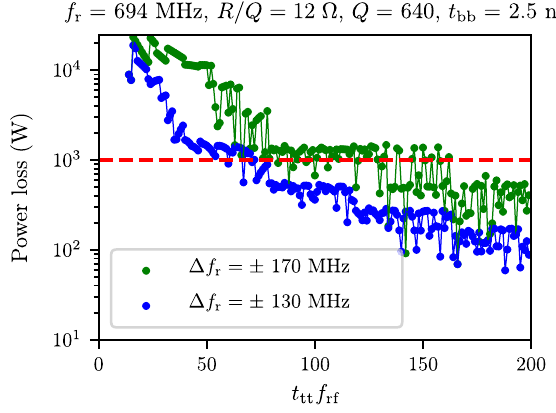
FIG. 19. Dependence of the maximum power loss in the resonant cases on the train spacing for different frequency shifts of HOM. For each train spacing the frequency of the mode was varied with the step of 3 kHz. For each train spacing, results are obtained from the scan of the resonant frequency with a step of 10 kHz. The horizontal line corresponds to the HOM coupler limit of 1 kW.